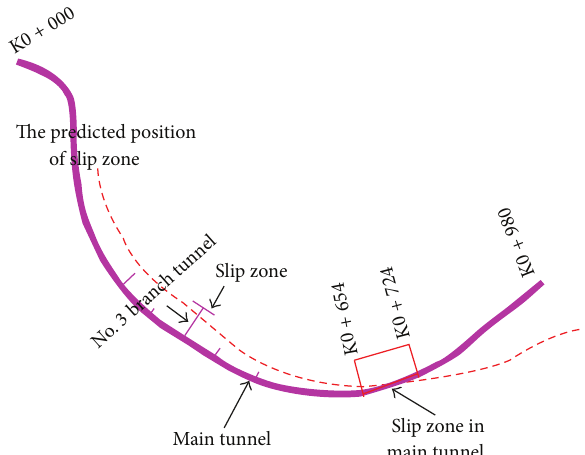
Figure 2: Schematic diagram of the exploratory tunnel in the Huangtupo landslide (plan view).